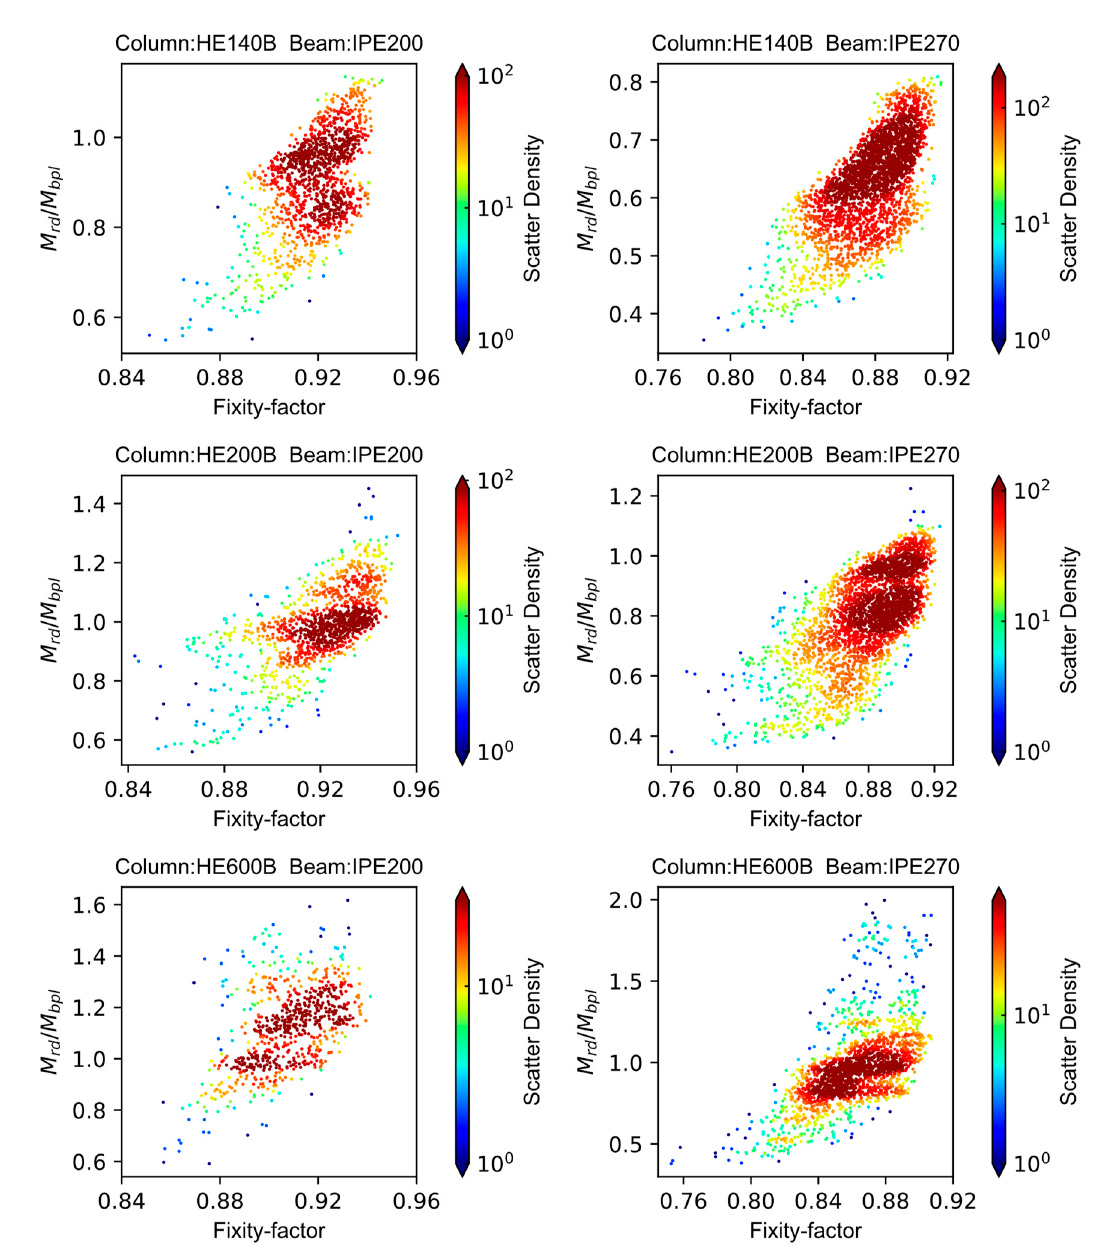
Figure 9. Scatter density diagrams of fixity-factor vs. moment coefficient for beam–column in Table 3,